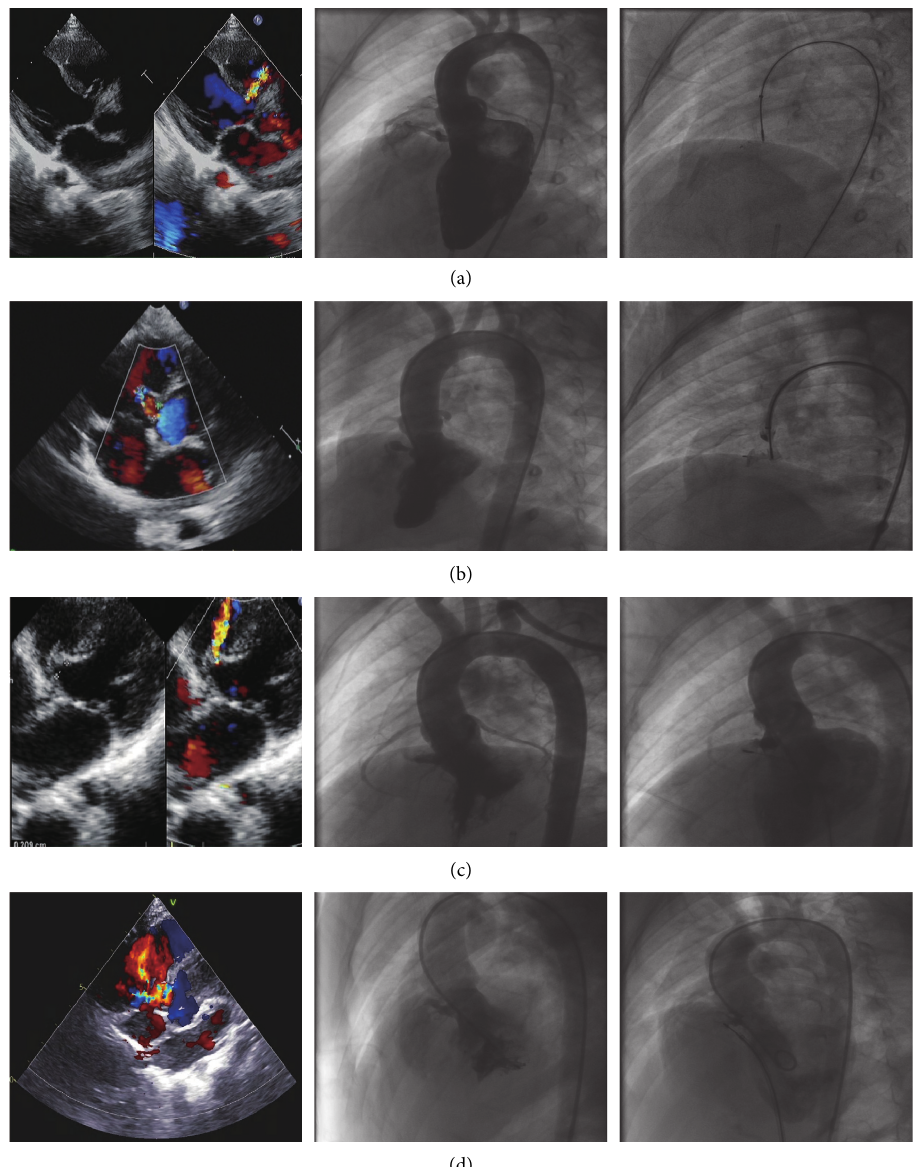
Figure 1: Transthoracic echocardiography (TTE) and angiographic findings considered suitable for ADO II implantation: (a) tubular aneurysm, (b) aneurysm with two constrictions, (c) aneurysm with an elongated conical appearance, and (d) aneurysm with multiple small